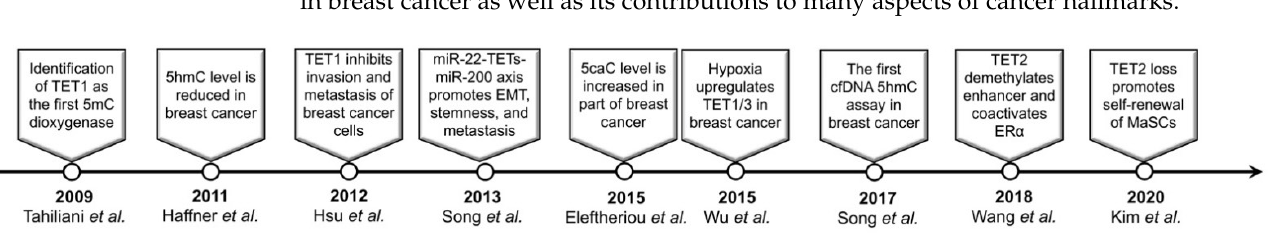
Figure 1. Milestones of the research for TET/5mC oxidation in breast